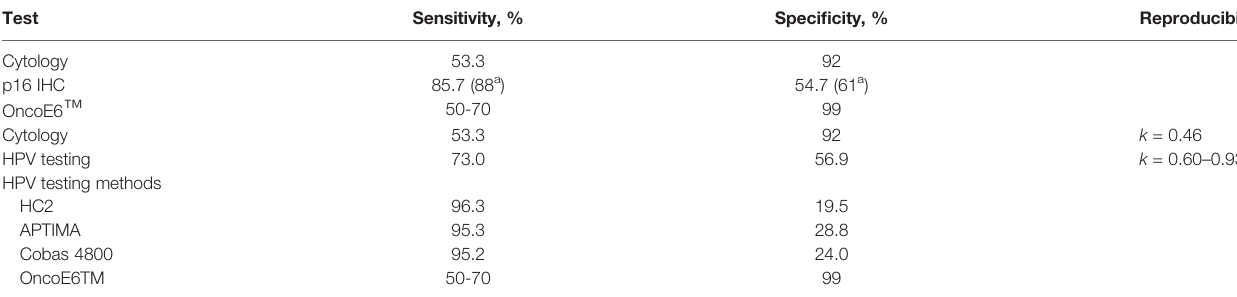
TABLE 8 | Summary of performances of the tests for